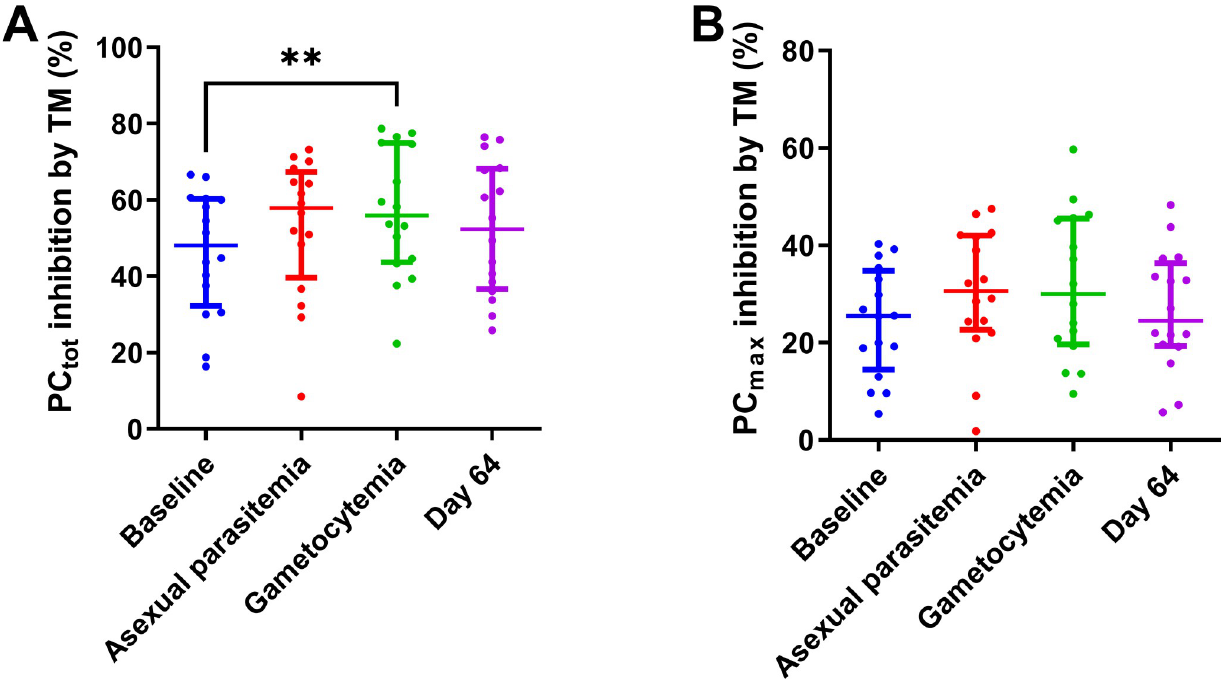
Fig 6. The inhibitory effect of thrombomodulin on prothrombin conversion in the four stages of plasmodium falciparum infection. (A) The thrombomodulin-induced inhibition of the total amount of converted prothrombin (PC tot ; (A)) and the maximum rate of prothrombin conversion (PC max ; (B)). Results are shown as the median and interquartile range, and �� indicates a p-value below 0.01.